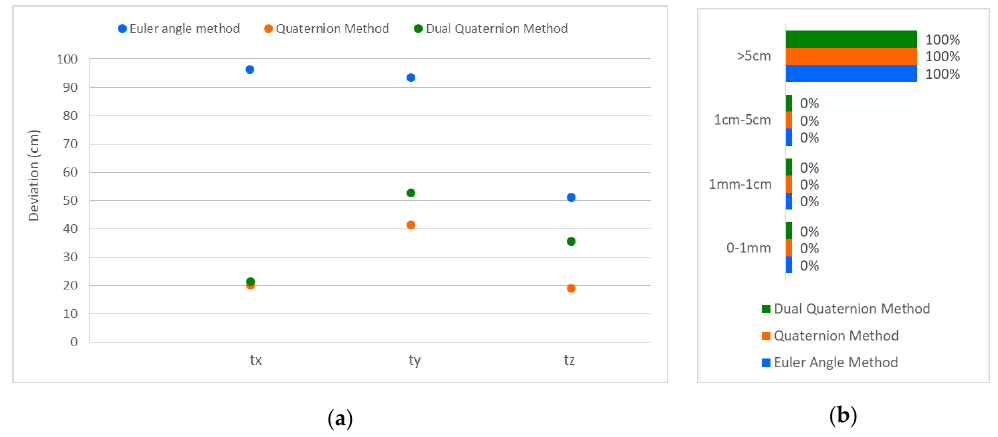
Figure 10. ( a ) Deviations in centimeters for translation per axis for all methods. ( b ) Histogram of deviations for translation per axis for all methods.